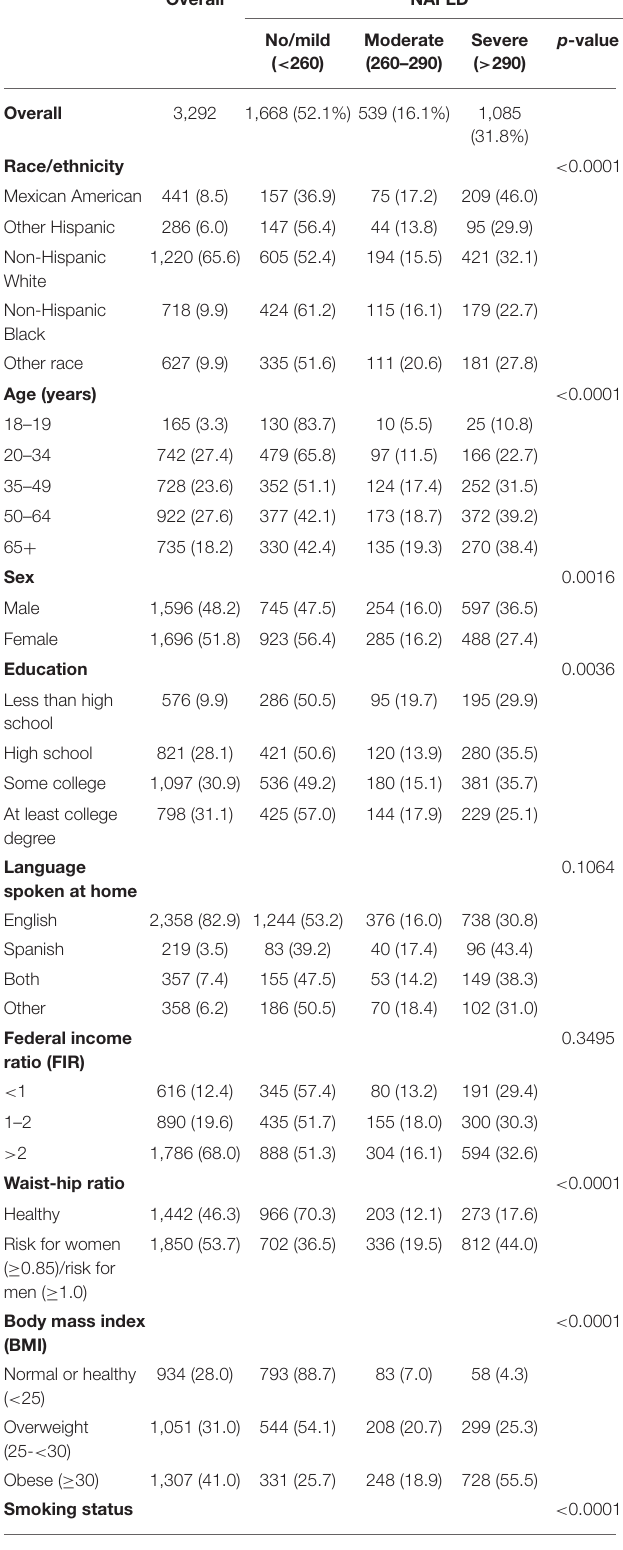
TABLE 1 | Population characteristics by NAFLD status, NHANES